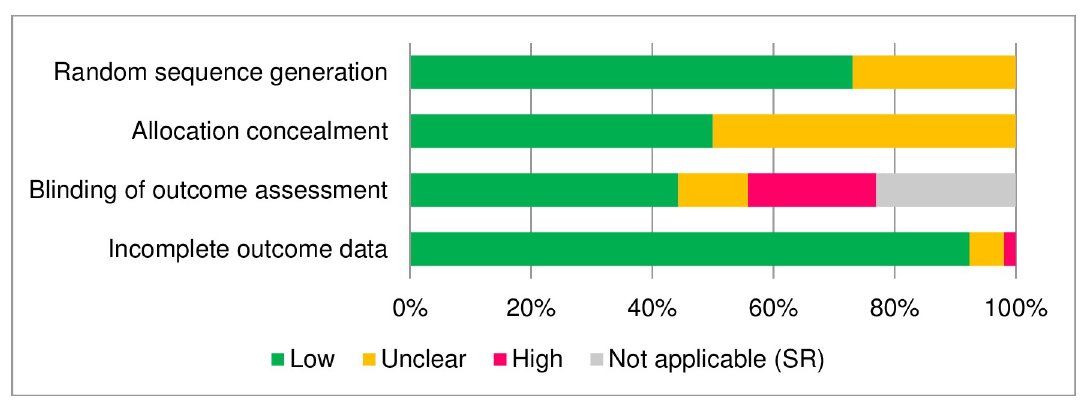
Fig 2. Risk of bias assessment. Note . SR = Self-report.